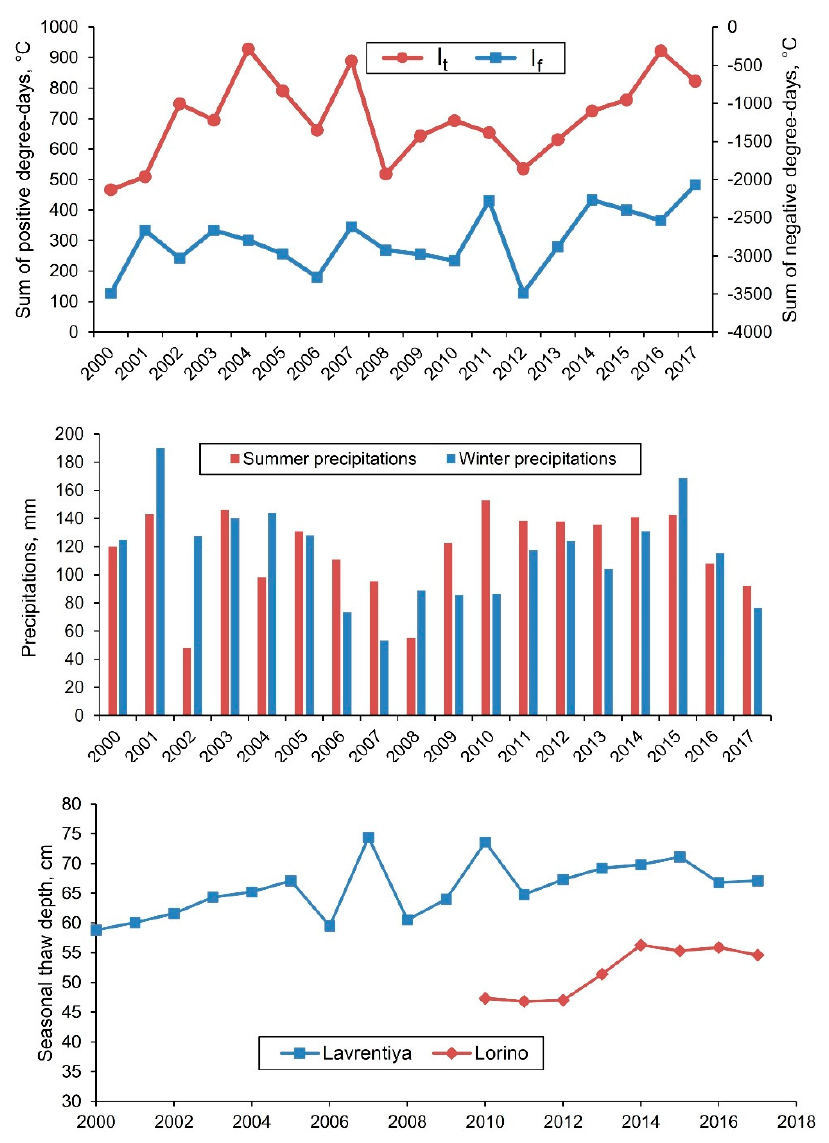
Figure 4. Thaw (I t ) and frost (I f ) indexes, summer and winter precipitation amounts, and seasonal thaw depths at Lavrentiya and Lorino CALM sites variations for 2000–2017.